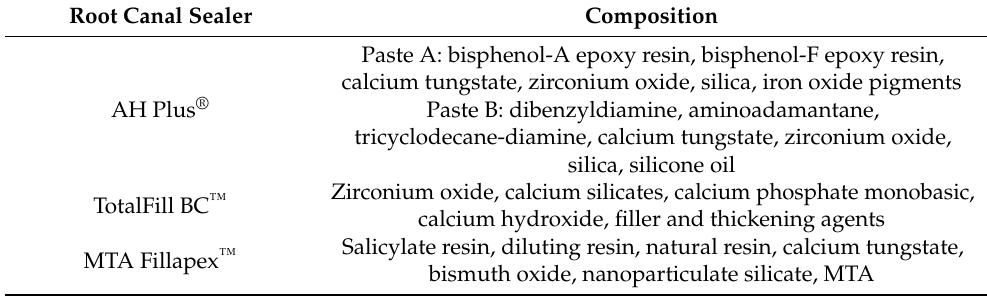
Table 1. Composition of root canal